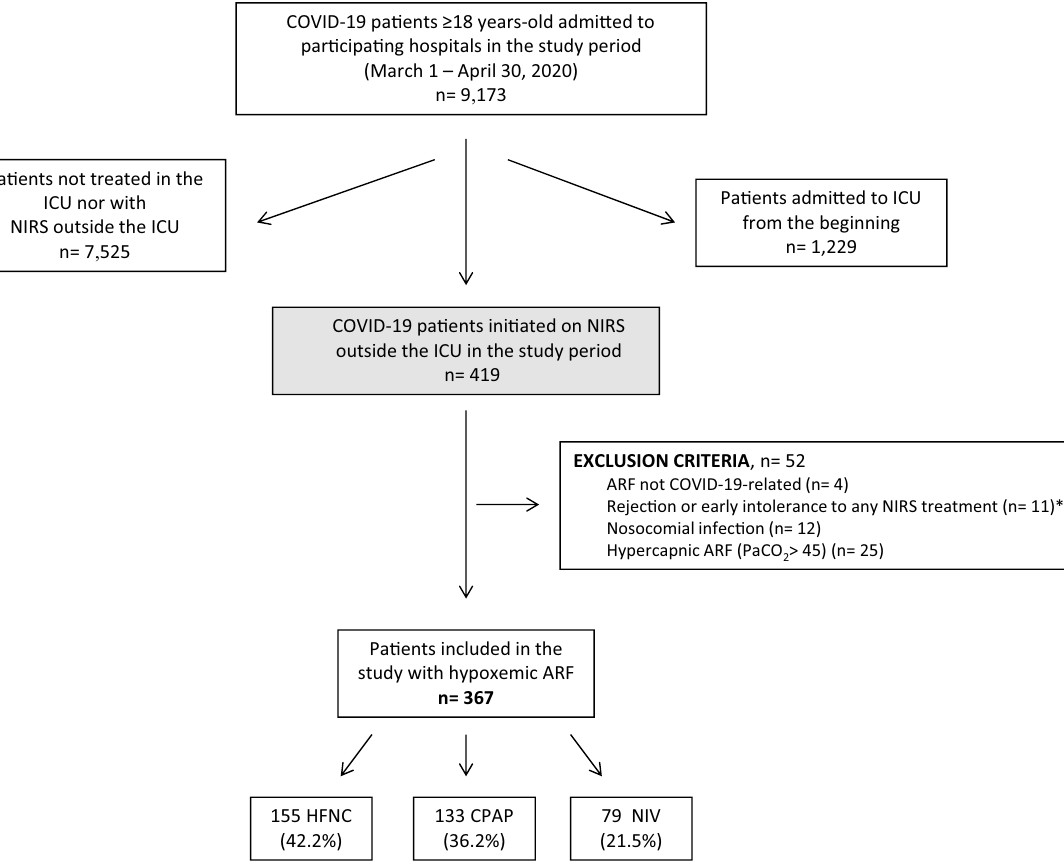
Figure 1. Flowchart. ARF acute respiratory failure, HFNC high-flow nasal cannula, ICU intensive care unit, NIRS non-invasive respiratory support, NIV non-invasive ventilation. *HFNC, n = 2; CPAP, n = 6; NIV, n = 3.